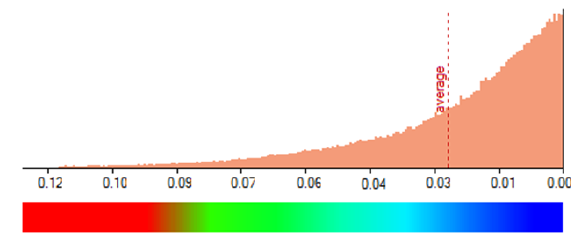
Figure 11. A diagram of the absolute deviations The values on both diagrams are in meter.